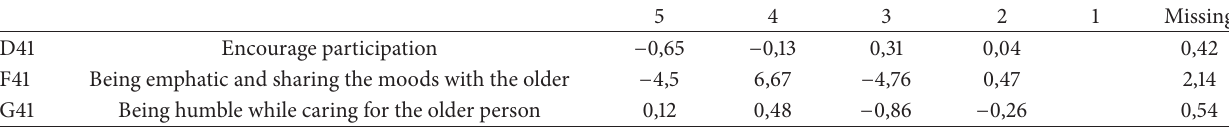
Table 15: Effects on distribution function when A11 fixed to “4” = 100%.